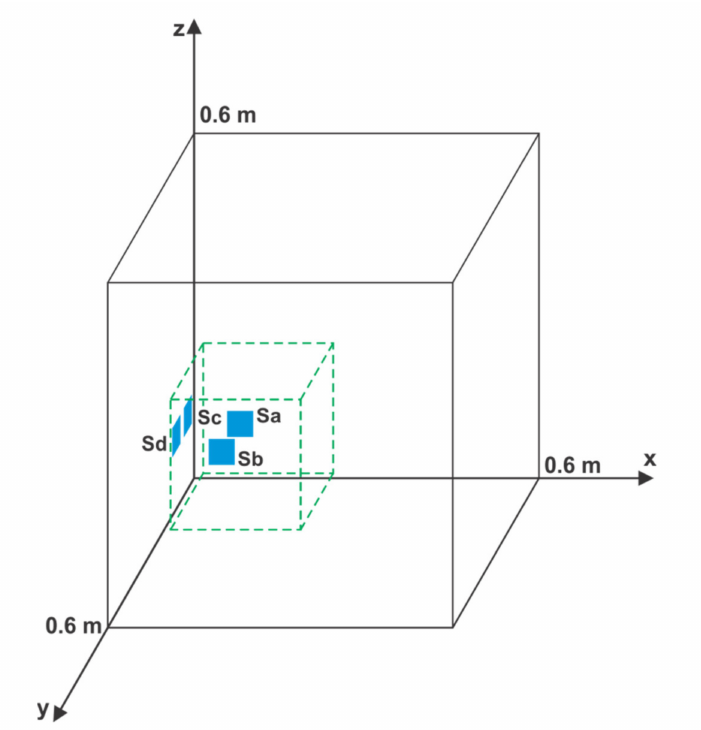
Figure 5. Nominal position of sensors S a , S b , S c , and S d ; area marked with a dashed-line paral- lelepiped, which includes PDs with ∆ g max lower than 0.05 m for a temperature change of 40 ◦ C, in the first